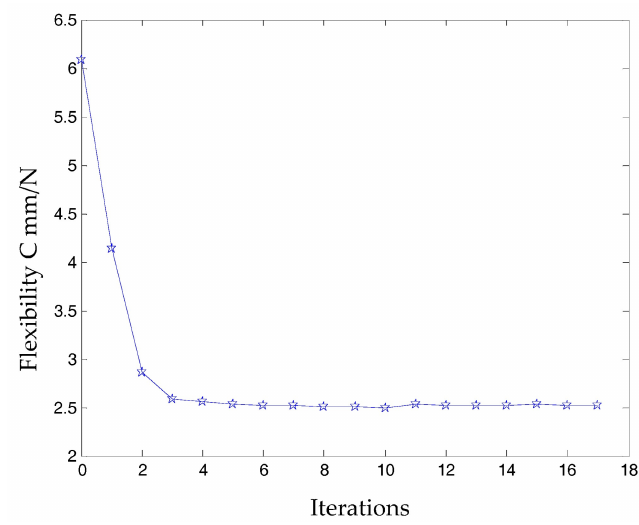
Figure 4. Topology optimization iteration procedure of the three-DOF spatially compliant mechanism.